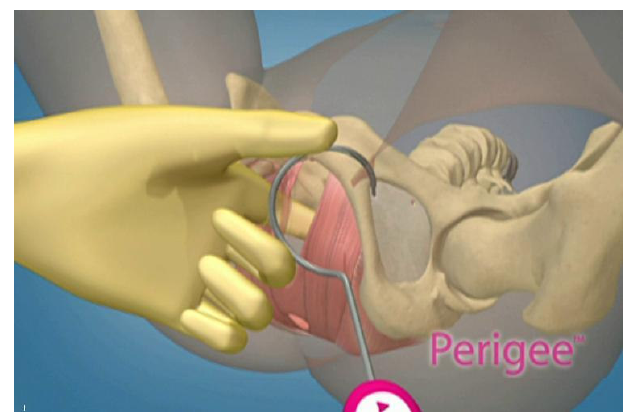
FIGURE 5. Superior needle pass of Perigee.